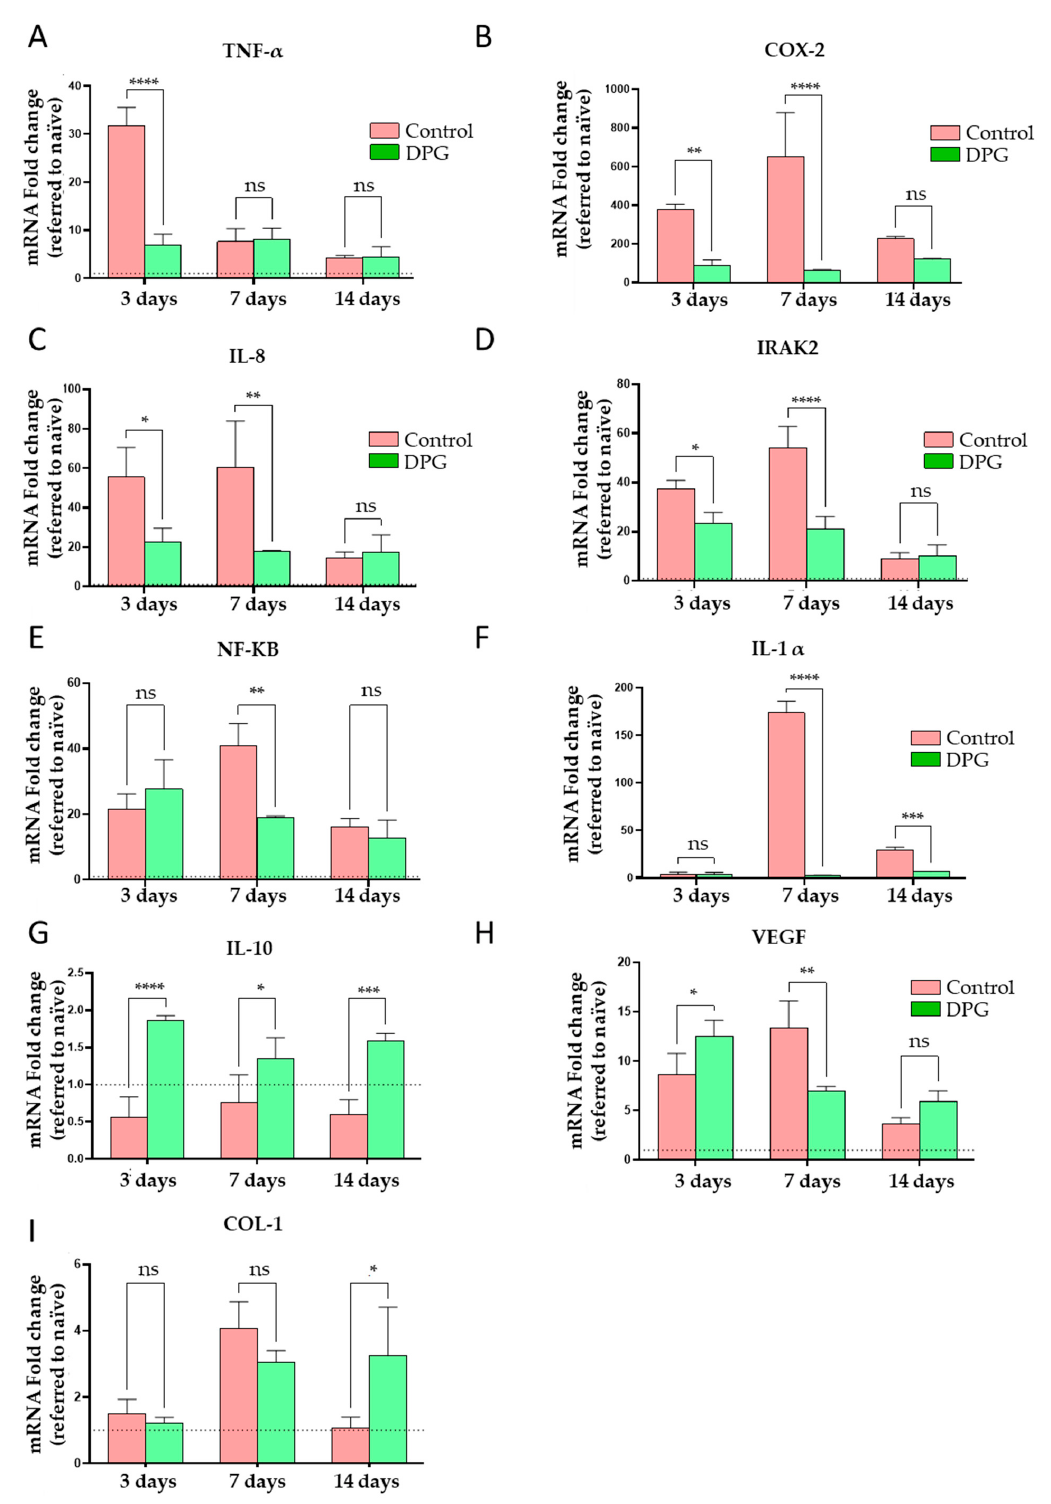
Figure 4. Quantitative analysis of the expression of mRNAs in the wound healing samples throughout the days of experimentation in the Control and DPG groups. ( A ) Tnf- α (**** p < 0.0001); ( B ) Cox-2 (** p < 0.01, **** p < 0.0001) ; ( C ) Il-8 (* p < 0.05, ** p < 0.01); ( D ) Irak-2 (* p < 0.05, **** p < 0.0001); ( E ) Nf-kb (** p < 0.01) ; ( F ) Il-1 α (**** p < 0.0001, *** p < 0.001) ; ( G ) Il-10 (**** p < 0.0001, *** p < 0.001); ( H ) Vegf (* p < 0.05, ** p < 0.01); and ( I ) Col-1 (* p < 0.05). Ns—not significant, * p < 0.05; ** p < 0.01; *** p < 0.001; **** p < 0.0001 when compared to the control